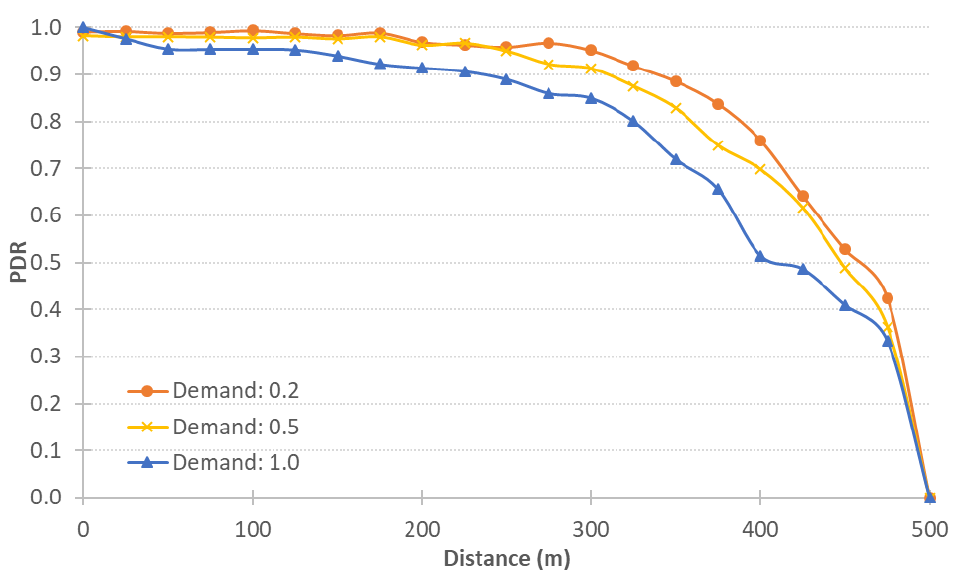
Figure 10. LA results at different demand levels.